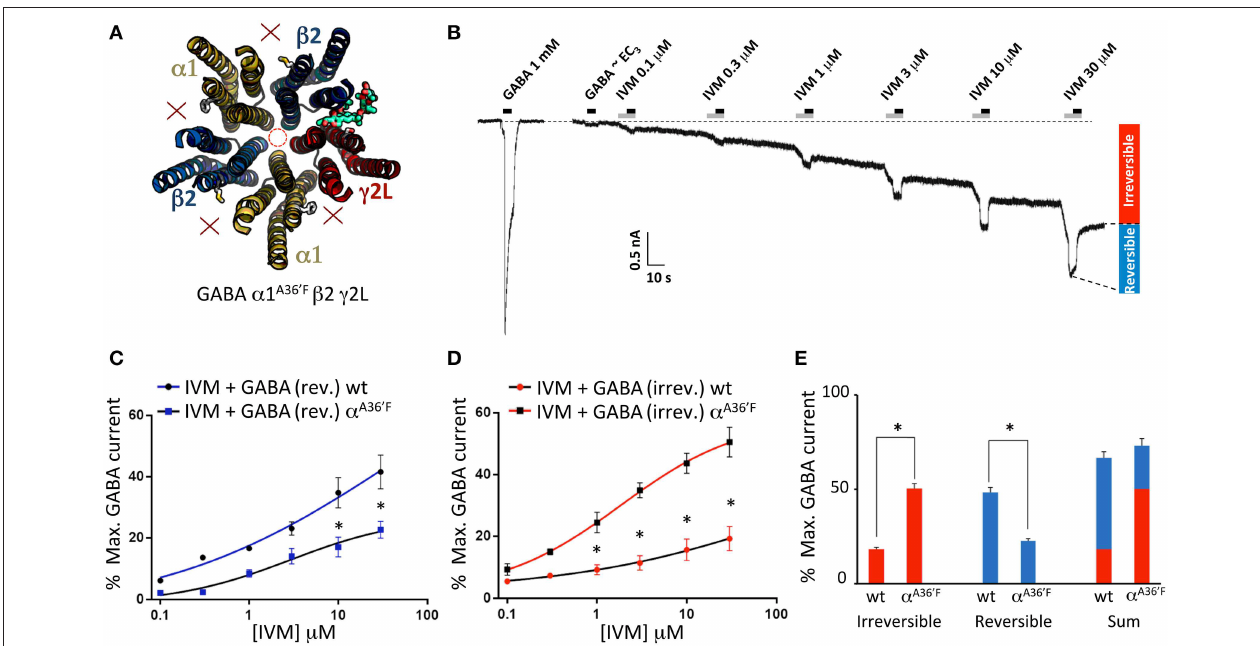
FIGURE 5 | Effects of ivermectin on α 1 A36 β 2 γ 2L GABA A Rs. (A) Structural model showing the location of the single ivermectin binding site. (B) Sample recording showing the effect of increasing ivermectin concentrations on EC 3 GABA-gated currents, with reversible (i.e., GABA-activated) and irreversible current increases indicated. (C) Mean concentration-response relationship of the reversible current component, compared with the corresponding wild type GABA A R data from Figure 1 . (D) Mean concentration-response relationship of the irreversible current component, compared with the corresponding wild type GABA A R data from Figure 1 . (E) Mean saturating magnitudes of reversible and irreversible ivermectin-modulated currents (defined as indicated in B ), and their sum, plotted as a percentage of EC 3 GABA-activated current, and compared to corresponding wild type data. * Represents significance of t -test P <